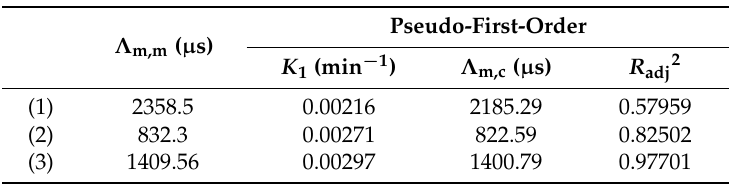
Table 4. Constants and correlation coefficients of pseudo-first-order kinetic models for NaCl (1), CaCl 2 (2), and CrCl 3 (3) adsorption onto γ -PGA/ ε -PL